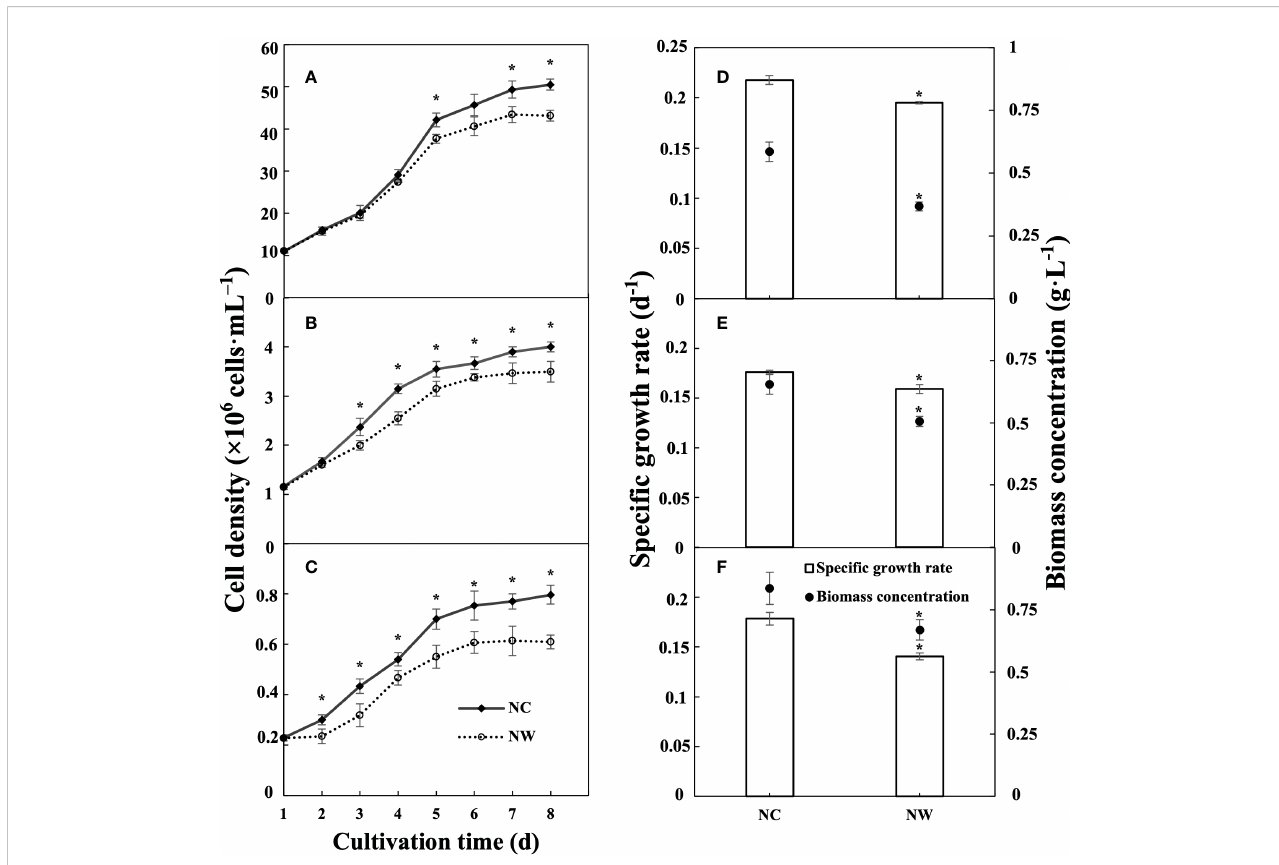
FIGURE 1 Growth performances of N. oceanica (A, D) , C. atomus (B, E) , and C. weiss fl ogii (C, F) . NC, nitrate-N concentration of 13.85 mg·L – 1 . NW, nitrate-N concentration of 5 mg·L – 1 . The one-way ANOVA analysis and the Tukey ’ s post hoc test were executed to estimate the differences. “ * ” indicates a signi fi cant difference ( P < 0.05) between NC and NW at the same time point. Data are displayed as the mean ± SD (standard deviation) (n =